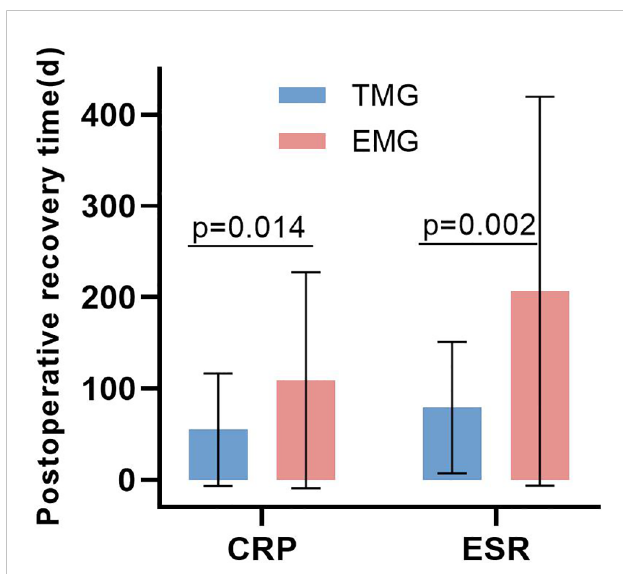
FIGURE 7 The comparison of the time for CRP and ESR to return to normal between the two groups. TMG, Targeted medication group; EMG, Empirical medication